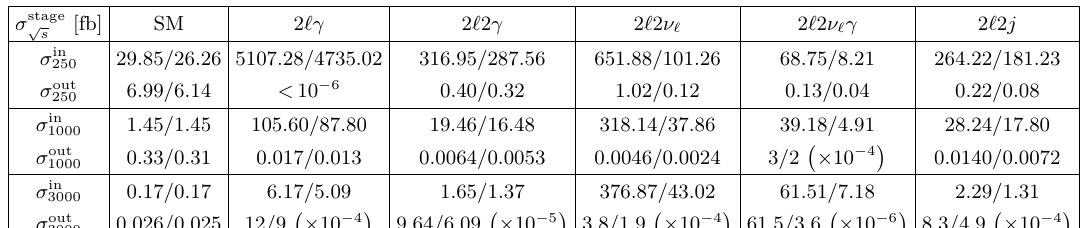
Table 4. Cross-sections, σ , in fb, for the Zh -like SM-driven signal e + e − → ‘ + ‘ − h and its dominant √ backgrounds before ( in ) and after ( out ) event selection at s = { 250 , 1000 , 3000 } GeV. We consider √ the left and right beam polarisations P , P for each s , reported as left/right (see text for details). e + e − For the t ¯ t , ‘ + ‘ − W + W − , and ‘ + ‘ − ZZ channels, σ in (in fb) ∼ 3.47/0.62, 4.44/0.41, and 0.22/0.12, respectively at 1 TeV. At 3 TeV, the respective numbers are 0.08/0.01, 1.77/0.21, and 0.06/0.03. √ For all cases, σ out < 10 − 6 fb. For s = 250 GeV, the kinematic phase space is not open for any of these three channels.